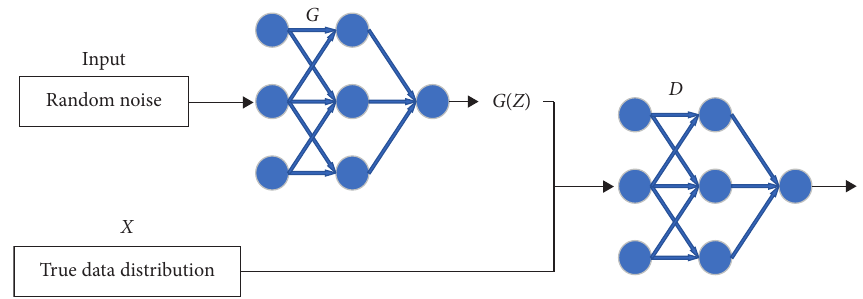
Figure 2: Structural diagram of GAN.